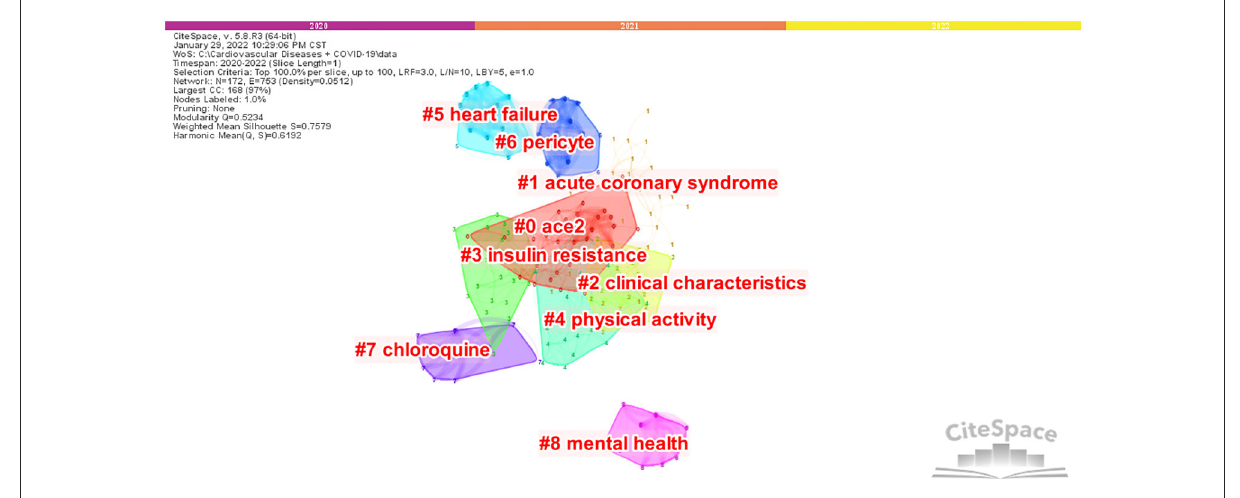
FIGURE8 Network of the main keywords’ clusters in the studies of CVDs and COVID-19 research.